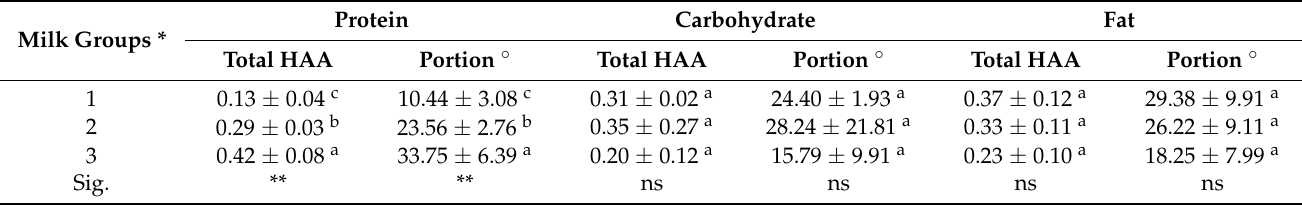
Table 7. The total HAA contents of milk samples grouped according to their protein, carbohydrate, and fat contents (mean ±